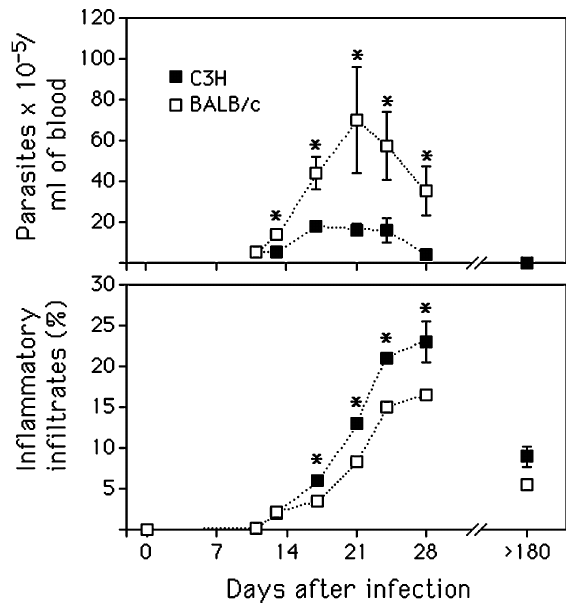
FIG. 1. Parasitemia and area of tissue inflammatory infiltra- tion (%) in skeletal muscle of acutely and chronically ( (cid:3) / 180 days p.i.) infected C3H and BALB/c mice. In both mouse strains, the inflammatory infiltrates were higher in infected than in non-infected mice, starting 11 days p.i. (p B / 0.05, t-test). Means 9 / standard errors of 4 (cid:1) / 6 mice/group are shown. *Differences between mouse strains are significant (p B / 0.05, t-test).